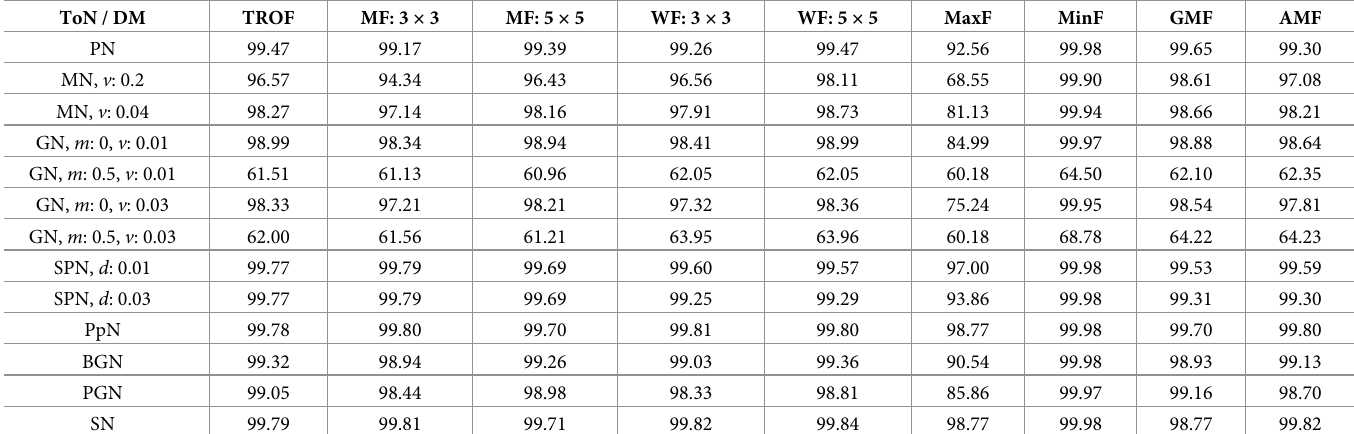
it is still very good for the denoising results of salt and pepper noise and Poisson noise. In addi- tion, the mean variance of the denoised image and the original image is an indicator of stability of denoising mehods. The mean variance is expressed by Eq (2) [2].